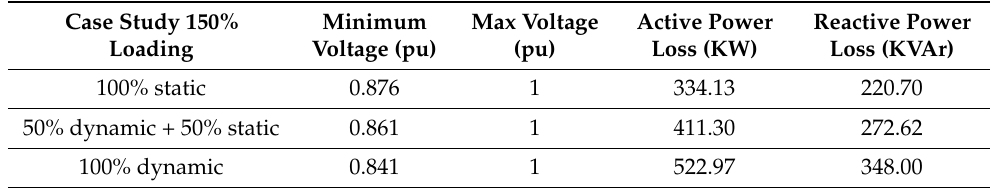
Table 2. Comparison between static and dynamic loads at 150% loading, i.e., a total load of (5370 + j2617) kVA.